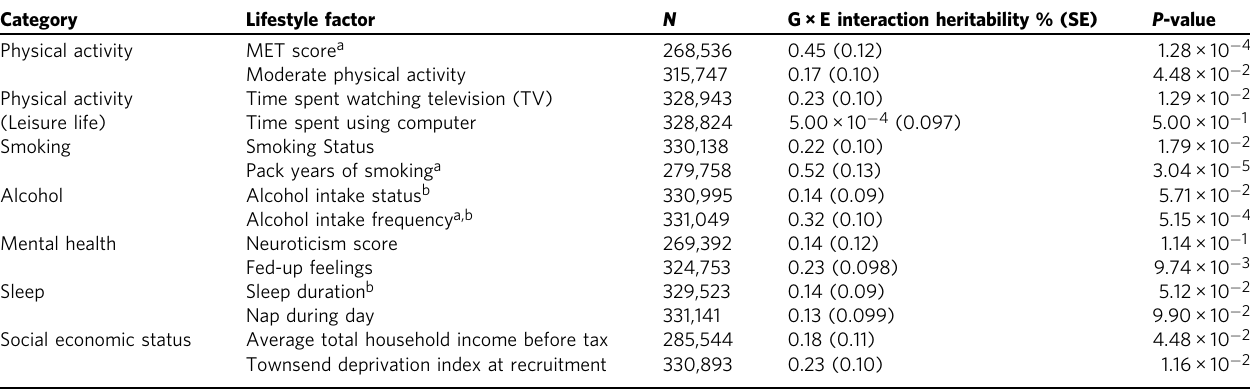
MET score metabolic equivalent of task score, SE standard error. a Indicates the statistically signi fi cant G×E interaction heritability based on the Bonferroni corrected P -value threshold ( P -value<3.57×10 − 3 ). b Indicates the GWIS after genomic control.